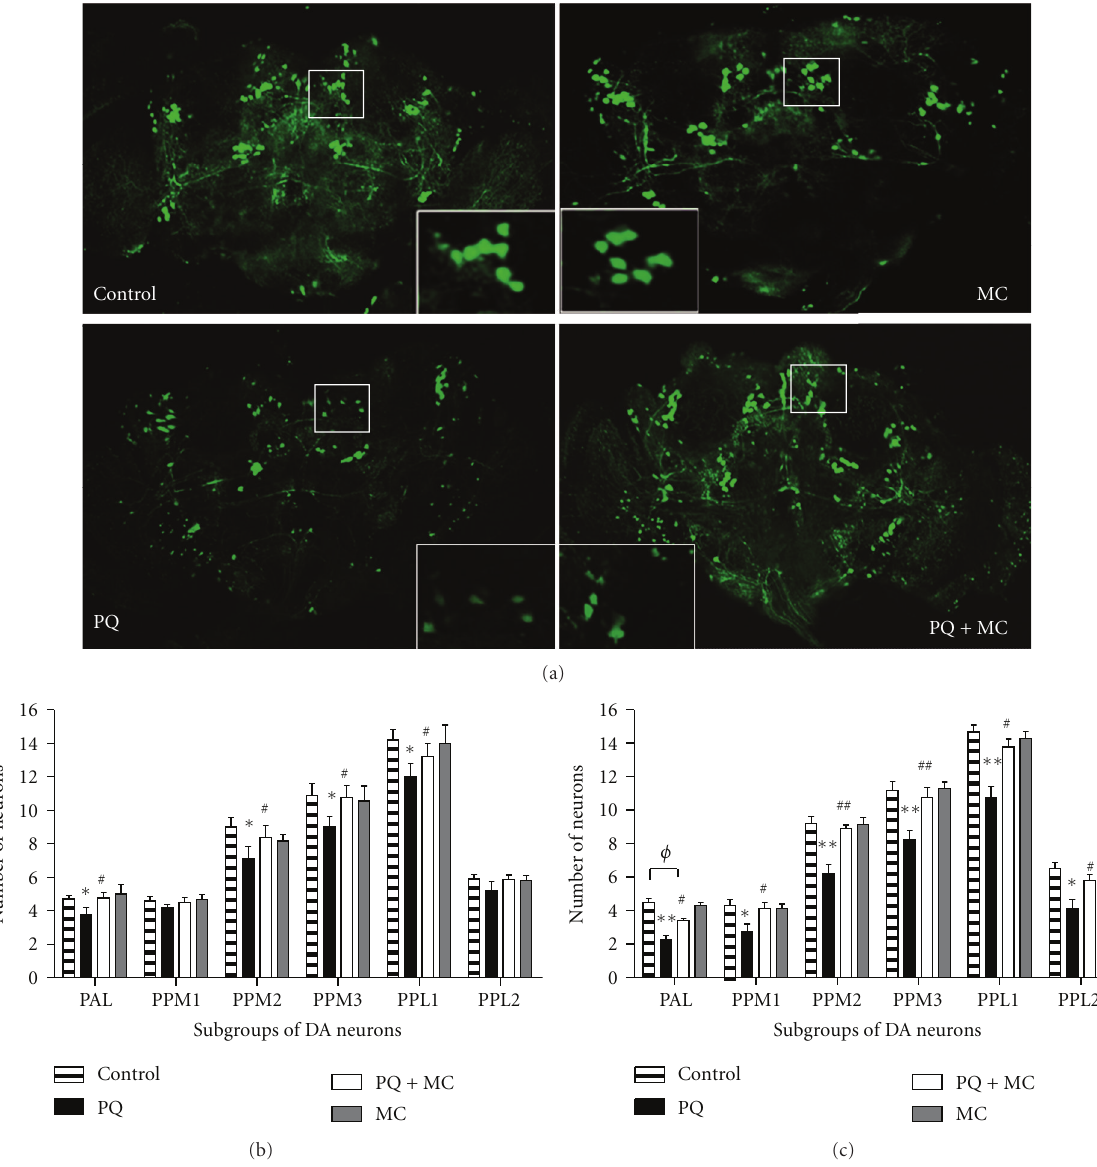
Figure 3: MC confers protection to dopaminergic neurons. (a) The e ff ect of a 24 hr exposure of adult males to sucrose (Control), 1mM MC alone (MC), 10 mM PQ alone (PQ), and 10 mM PQ with 1mM MC (PQ + MC) on the dopaminergic neurons of TH-GAL4; UAS-eGFP adult brains. The inset in each image demonstrates the change in the morphology and number of the PPM2 subgroup of neurons. The exposure to MC alone (MC) and sucrose (control) does not alter the number or morphology of the dopaminergic neurons. The addition of MC to PQ delays neuron loss and onset of abnormal neuron morphology relative to PQ only. Scale bar for whole brain images = 100 μ m. (b) and (c) MC delays PQ-induced selective loss of dopaminergic neurons. The average number of neurons per subset was determined 24hr (b) and 48hr (c) after the initiation of feeding and shows that MC delays, but does not prevent, PQ-mediated neuronal loss in di ff erent dopaminergic neurons. Each subset of dopaminergic neurons was scored separately in 15–25 brains. The significance of the di ff erence in each neuron cluster between the PQ-treated and control groups and between the PQ-treated and co-fed groups is indicated as ∗ and # , respectively, where ∗ = P < 0 . 05, ∗∗ = P < 0 . 005, # = P < 0 . 05, and ## = P < 0 . 005. φ represents the significant di ff erence between control and PQ with MC co-fed brains where φ = P < 0 . 05. Error bars represent standard error of the